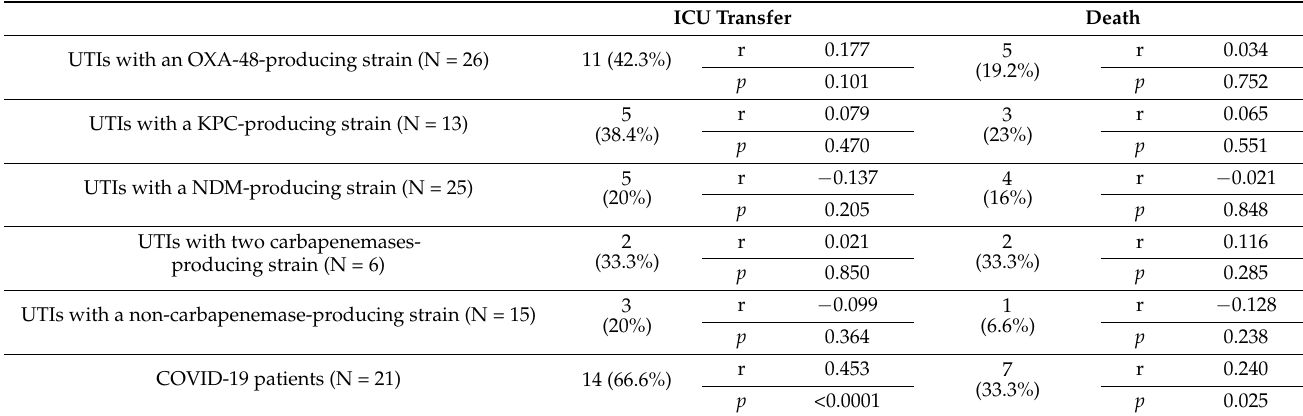
Table 5. Correlation between the type of carbapenemase produced/COVID-19 and the patients’ outcome. ICU Transfer Death